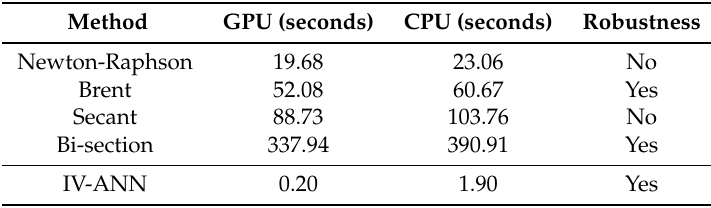
Table 8. Performance comparison: CPU (Intel i5, 3.33GHz with cache size 4MB) and GPU(NVIDIA Tesla